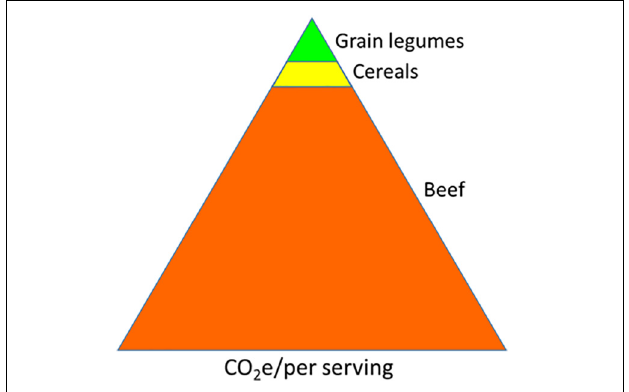
FIGURE 1 | Comparison of carbon footprint generated by per unit serving of different food types. The areas in the triangles are approximate to carbon footprint values